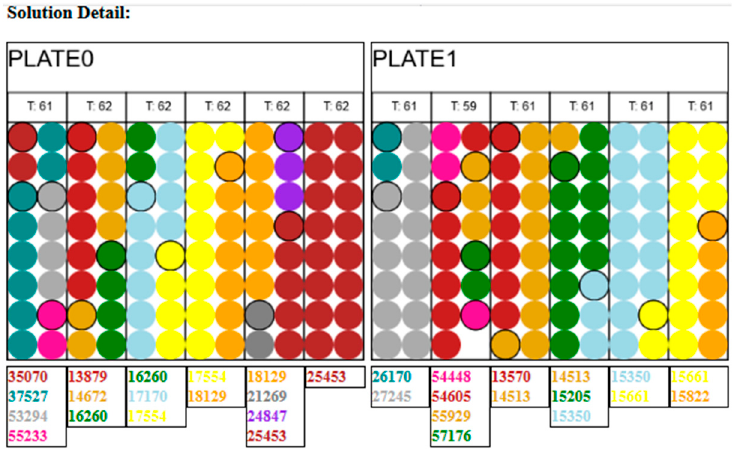
Figure 2. Example of algorithm output in the web